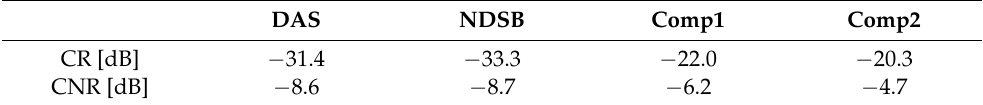
Figure 6. B-mode images of experiment cyst phantom. ( a ) DAS image ( b ) NDSB image ( c ) Comp1 image ( d ) Comp2 image. Table 2. Contrast-ratio and Contrast-to-noise ratio for Figure 6.